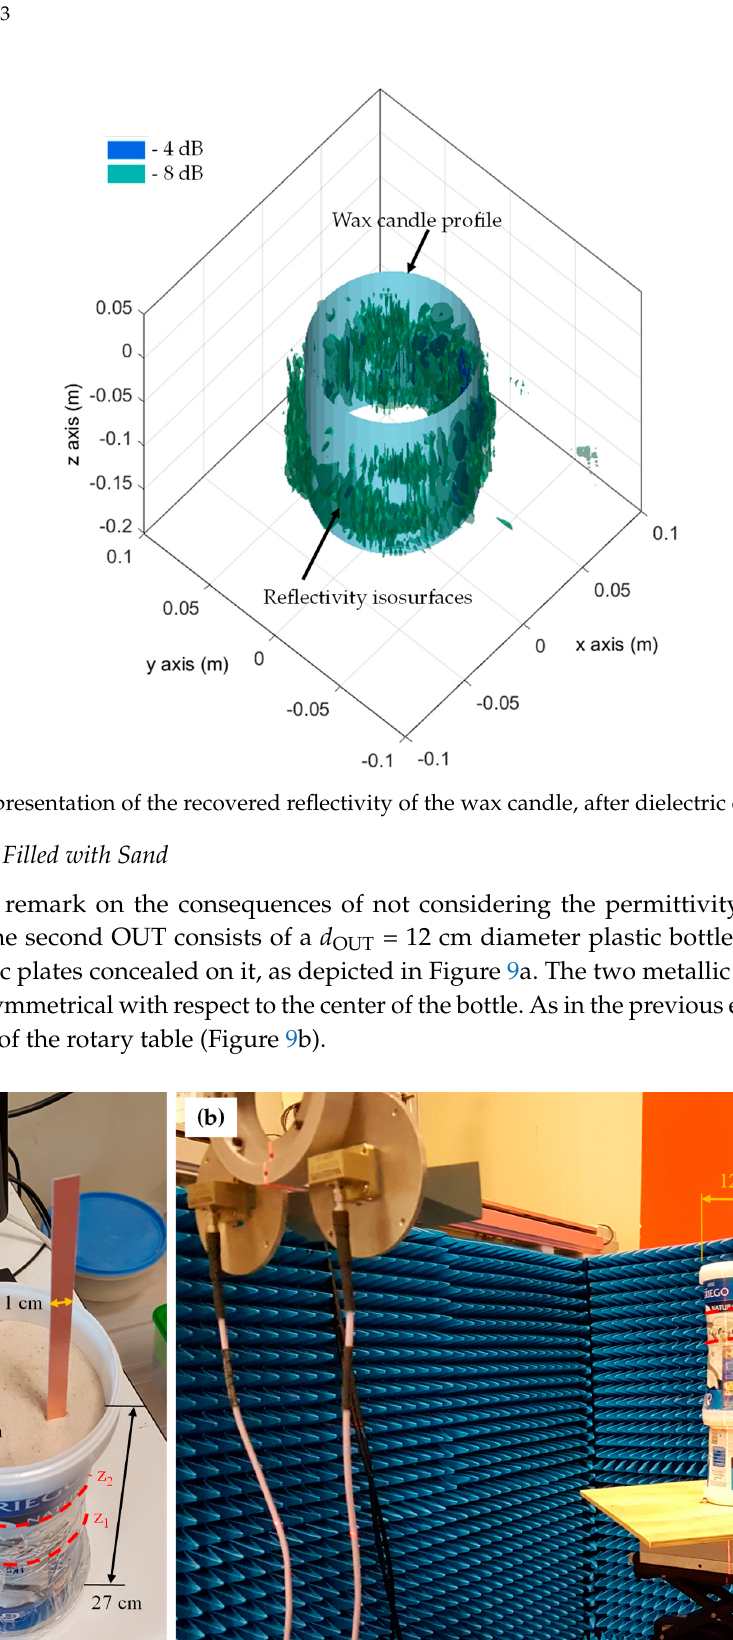
Figure 10. Reflectivity calculated for each observation angle as a function of the distance from the Tx/Rx antennas, for a XY slice (z 1 = − 13 cm with respect to the top of the plastic box). Air-sand (front reflection) and sand-air (rear reflection) interfaces are noticed, as well as the stronger reflection in the metallic plates. If this reflectivity image is converted into cartesian coordinates by applying Equation (12), the image depicted in Figure 11a is obtained. Not only the sand-air interface (#2) is shifted backwards, but also the rear reflection of the metallic plates is imaged outside the sand box. The reason is that the displacement of the rear reflection due to free-space propagation conditions is greater than the distance from the metallic plates to the plastic bottle. If another slice is chosen ( z 2 = − 7 cm), the same effect can be observed (Figure 11b). Thus, there is a clear need for using an estimate of the permittivity of the sand in order to recover a correct reflectivity image of the OUT. As in the previous example, conductivity and permittivity can be estimated from the uncorrected reflectivity depicted in Figure 10.